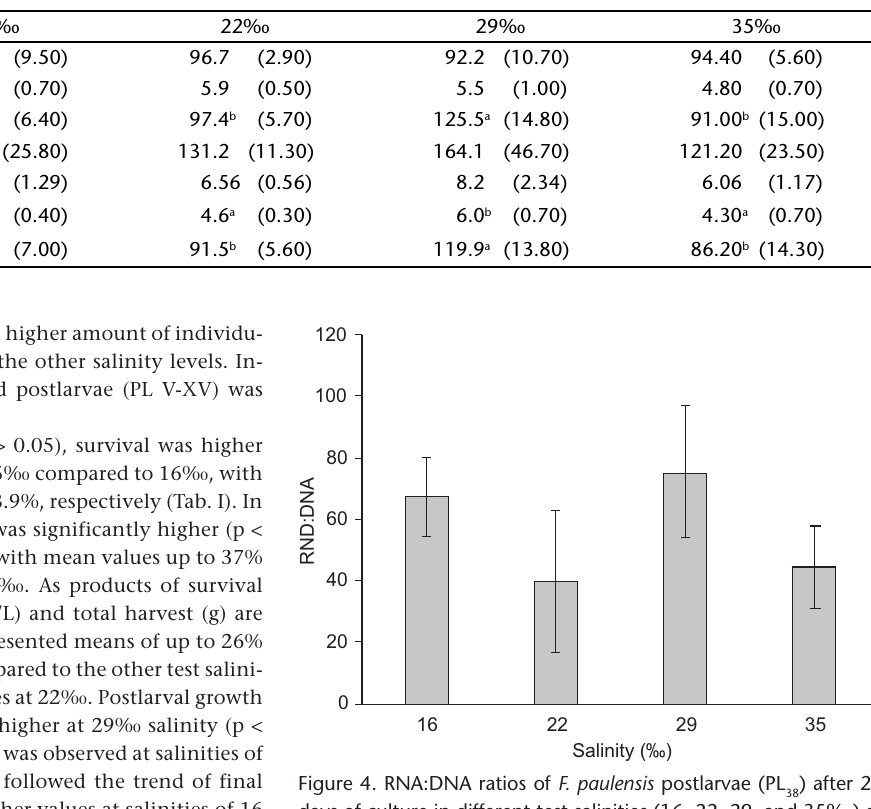
Table II. Correlation of growth rates and total harvest with RNA:DNA ratios of F. paulensis postlarvae (PL